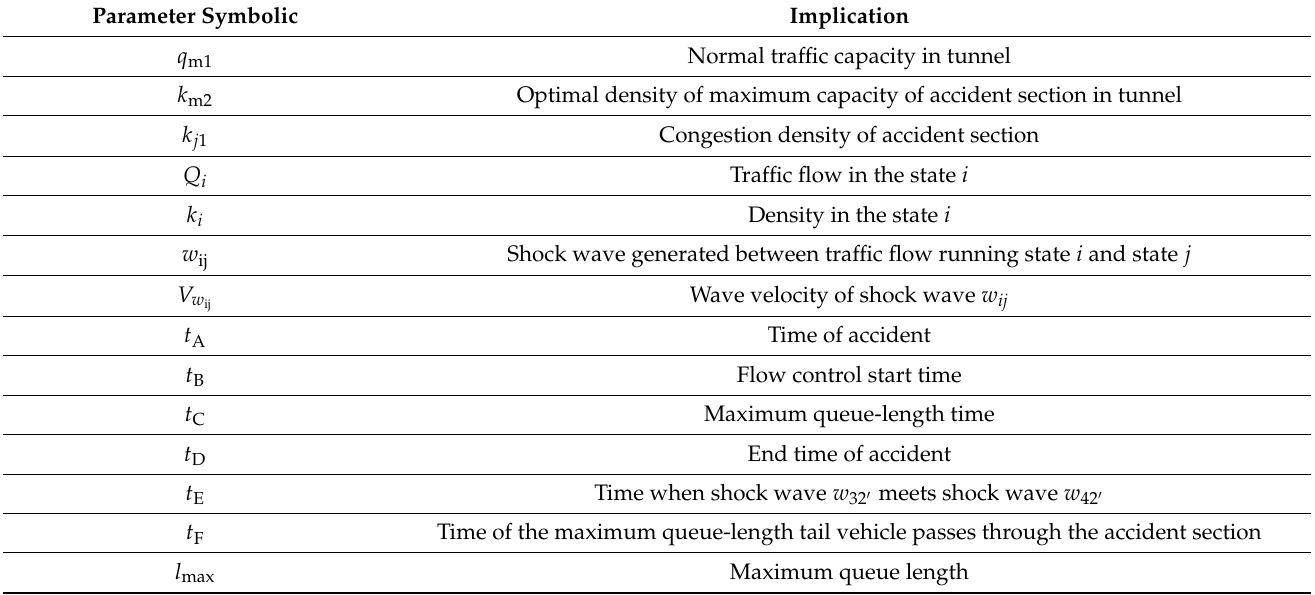
Table A1. Parameter